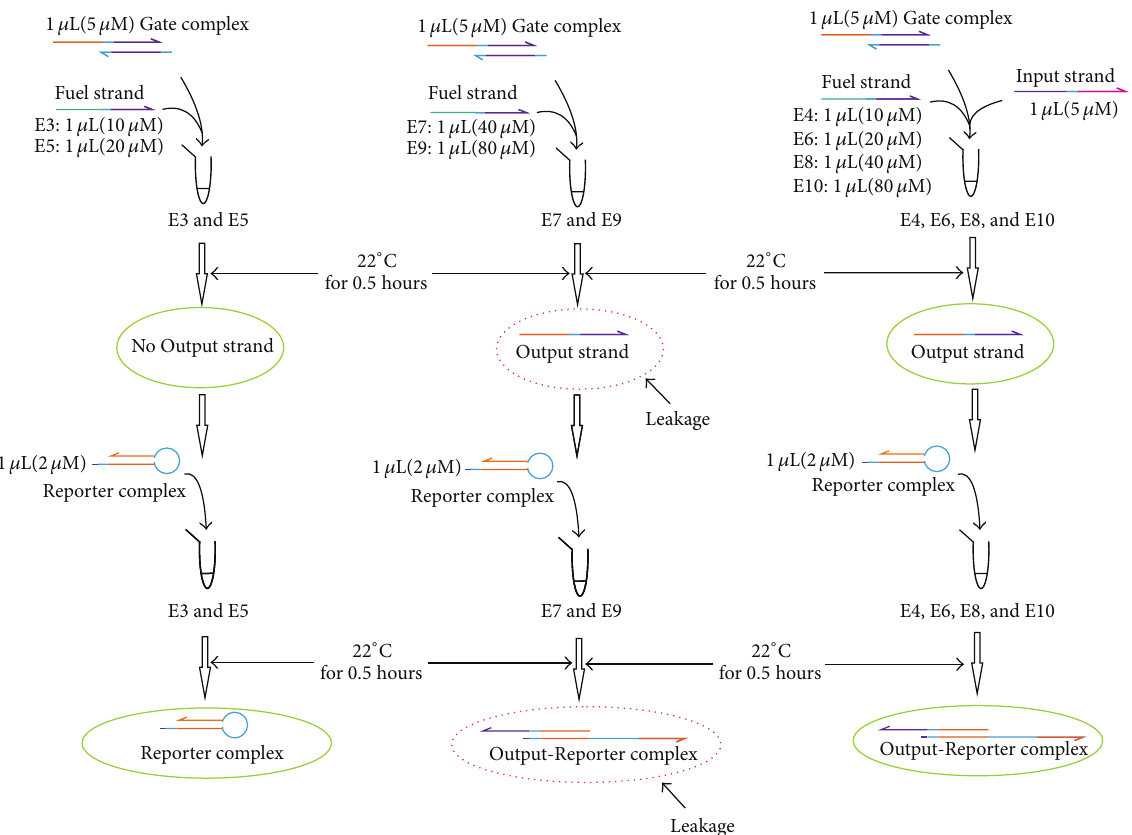
Figure6:Theproceduresofexperimentstoanalyzetheinfluenceofreactiontime(16/0.5hours)toleakyreactionofDNAstranddisplacement with different concentration of Fuel strands.